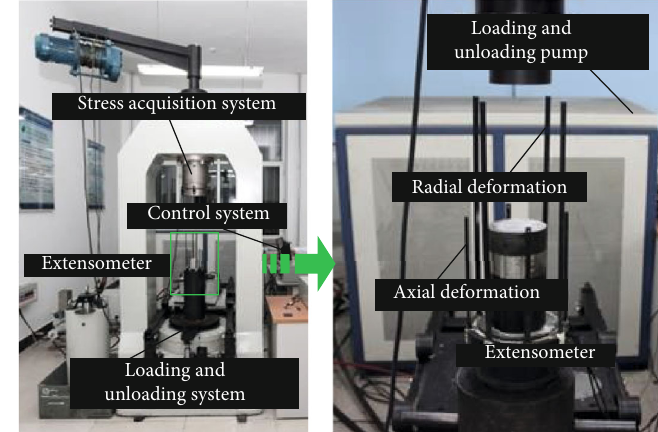
Figure 8: Rock testing machine.